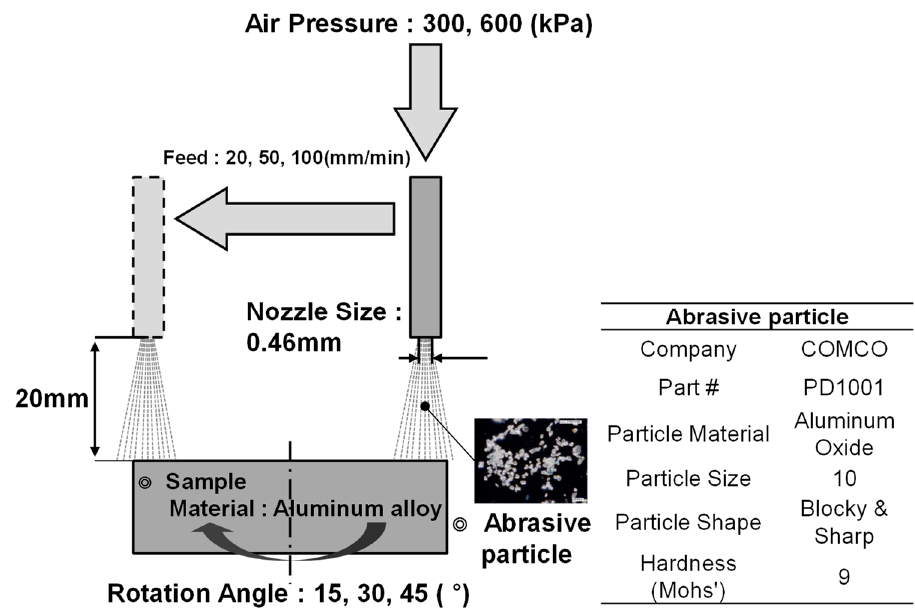
Figure 3. Microschematic diagram of the experimental machining of microsurface textures for friction reduction using the micro-AAJ machining system. Table 1. Micro-AAJ machining conditions.